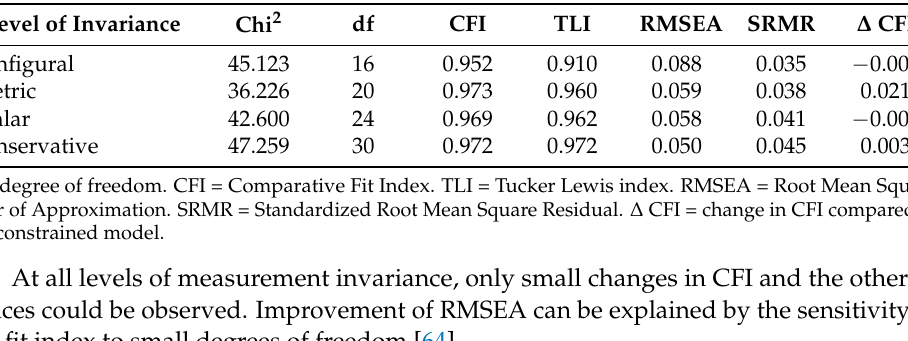
Table 7. Measurement invariance of the final HCS-G model regarding